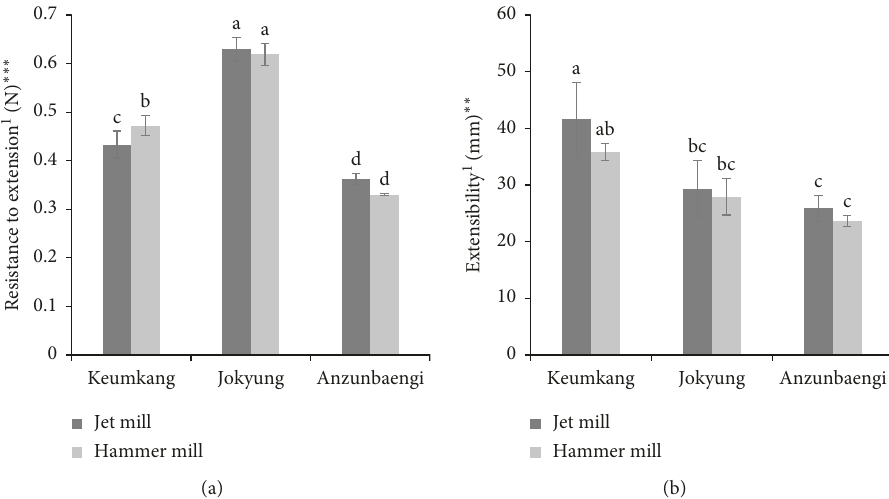
Figure 2: Resistance to extension (a) and extensibility (b) of WWF milled with jet mill and hammer mill. Significantly different at p